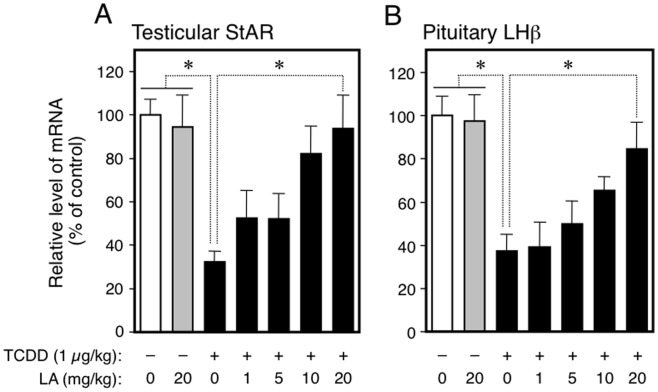
Dose-effect relationship for LA-assisted recovery from a TCDD-induced reduction in the fetal expression of mRNAs coding testicular StAR (A) and pituitary LHβ (B).Testicular StAR and pituitary LHβ mRNAs in the fetuses (GD20) were analyzed after maternal exposure to TCDD (GD15) and LA (GD15-20) by RT-PCR. LA was given to dams at different doses indicated in the figure. See also the legends to Figs. 1 (StAR analysis) and 3 (LHβ analysis) for the details of data processing. In Experiment (A), each bar represents the mean ± SEM of 6–10 fetuses each 2 of which were removed from different dams. In (B), each bar represents the mean ± S.E. of 3–5 pooled fetal pituitaries which were removed from different dams. *p<0.05, comparison between groups indicated.